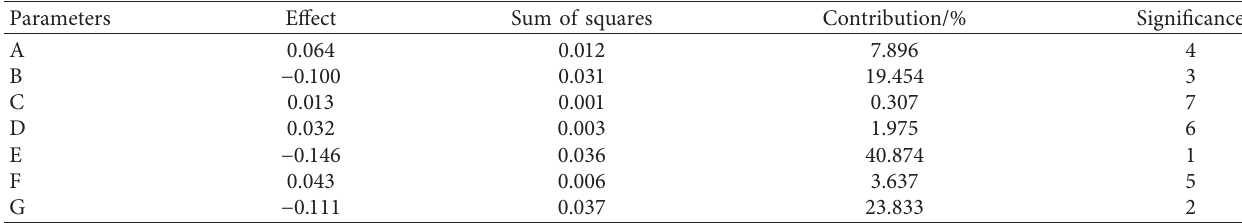
Table 4: Analysis of the significance of parameters in Plackett-Burman experiment.